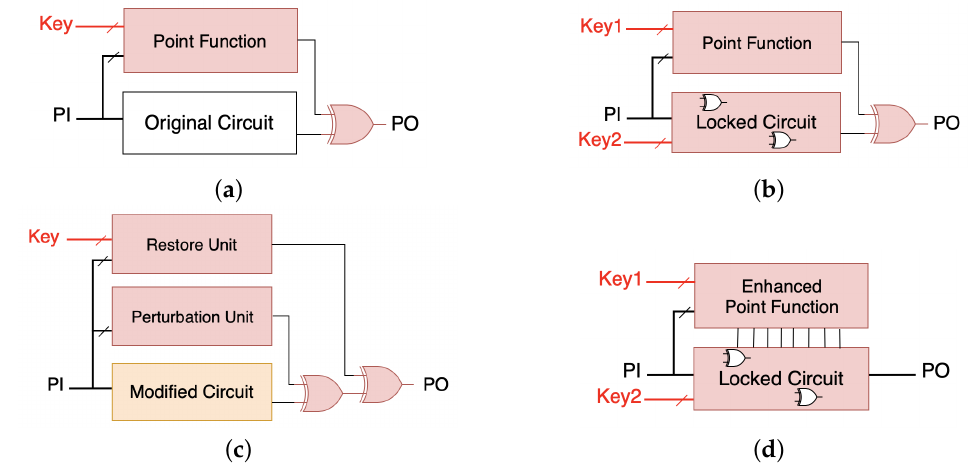
Figure 4. General structures of PSLL: ( a ) point-function based, ( b ) compound (point-function + logic locking), ( c ) CAC, ( d )